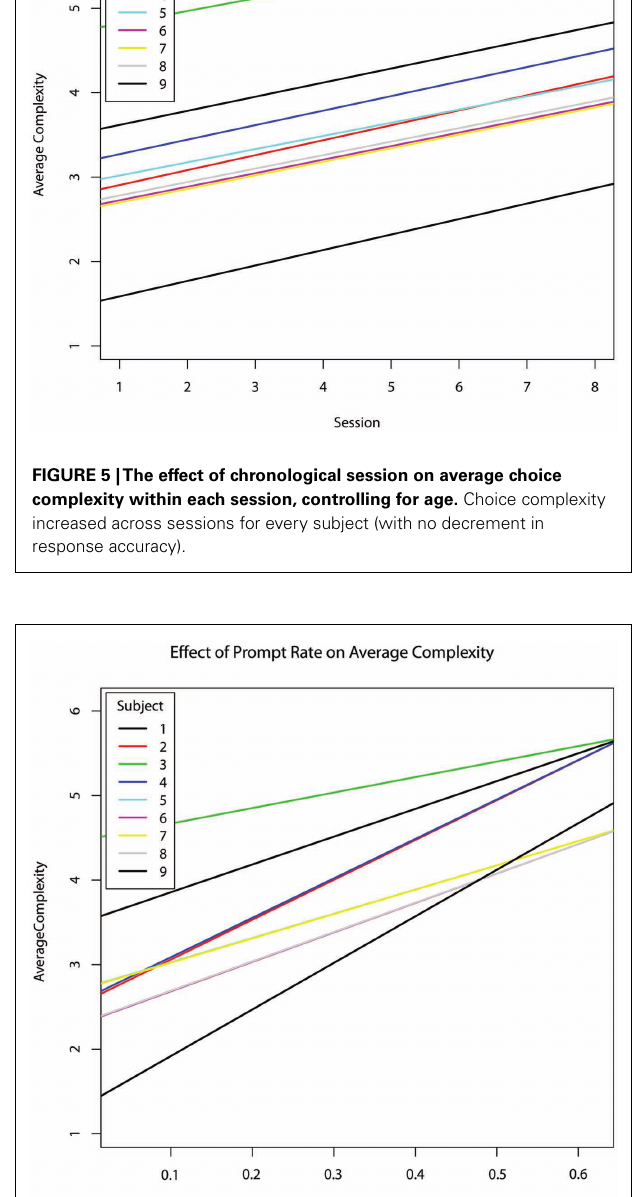
FIGURE 4 | Fraction of responses scored as successful within each session as a function the fraction of time spent in overtly engaged attention within each session. No overall relationship was present. For all but one of the nine subjects, the relationship between overtly engaged attention and success rate was negative; that is, in these eight subjects overt measures of attention to task predicted poorer task performance.